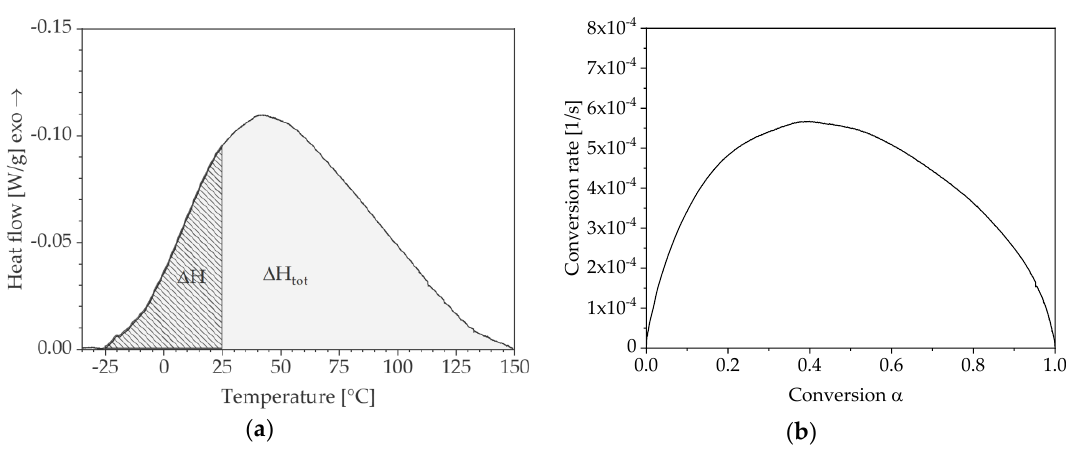
Figure 1. Determination of reaction-specific parameters based on differential scanning calorimetry (DSC) thermograms: ( a ) reaction enthalpy; ( b ) conversion rate against conversion.